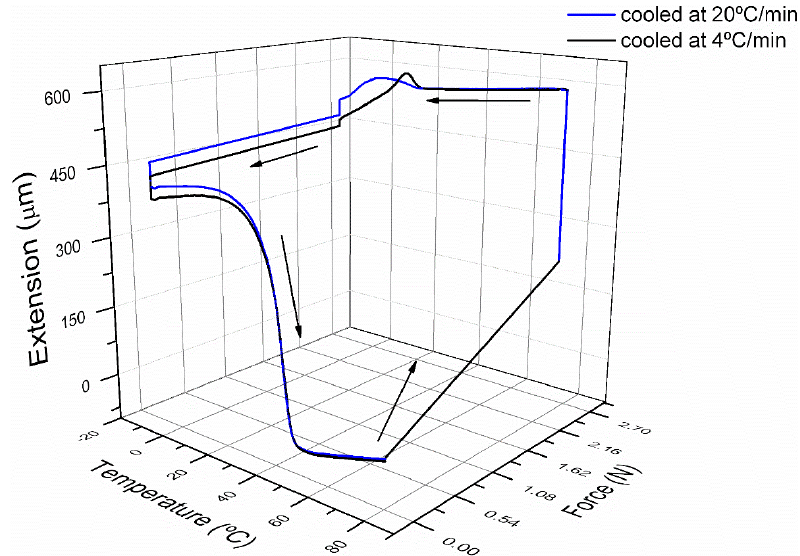
Figure 7. Thermomechanical cycle of PCO+2%DCP sample elongated at 2.5 N force and cooled at different rates.